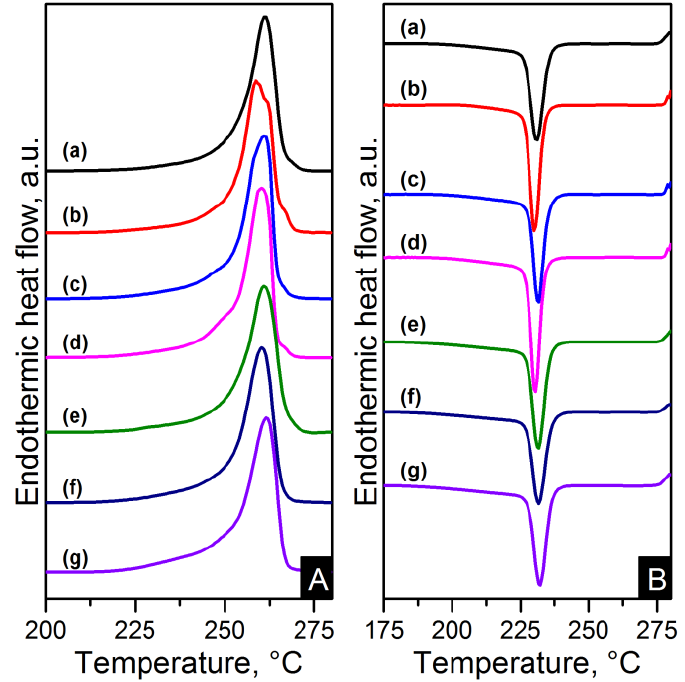
Figure 11. DSC ( A ) heating and ( B ) cooling thermograms of: ( a ) pure PA66; ( b ) PA66/01RGO; ( c ) PA66/05RGO; ( d ) PA66/10RGO; ( e ) PA66/01GO; ( f ) PA66/05GO and ( g )